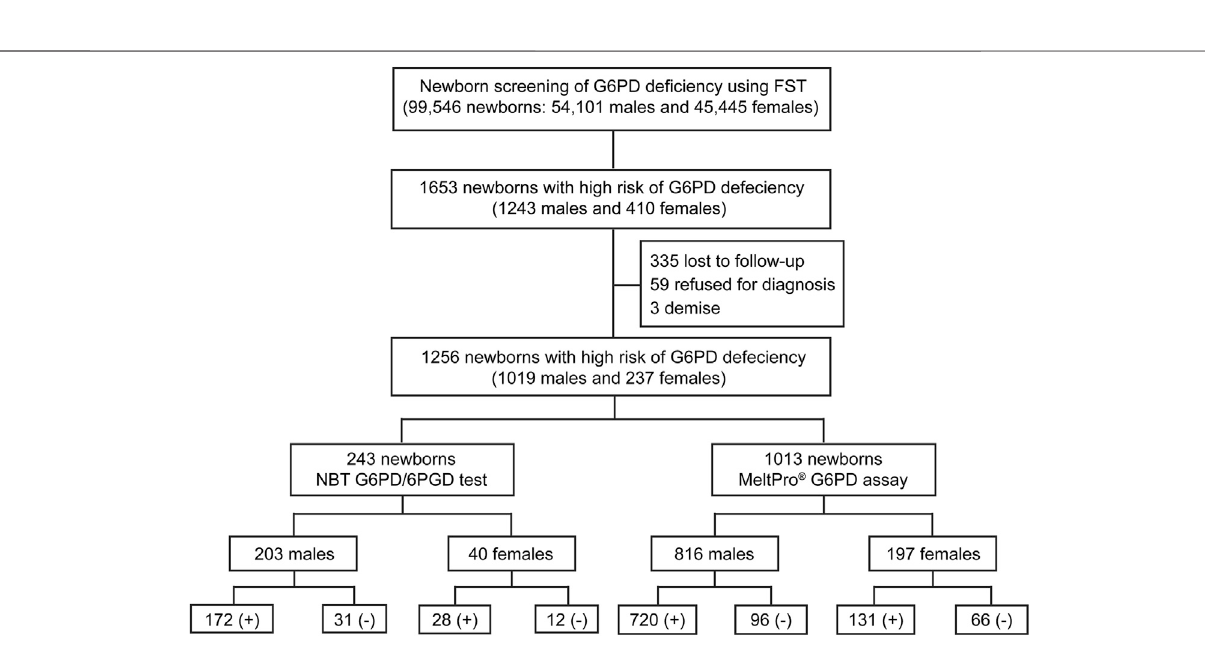
FIGURE 3 | Flowchart showing an overview of the results from newborn screening and diagnostic tests for G6PD de fi ciency. FST, fl uorescent spot test; G6PD/ 6PGD(+),G6PDde fi ciencypositive;G6PD/6PGD( − ),G6PDde fi ciencynegative;MeltPro ® G6PDassay(+),targetvariantsdetected;MeltPro ® G6PDassay( − ),notarget variants identi fi